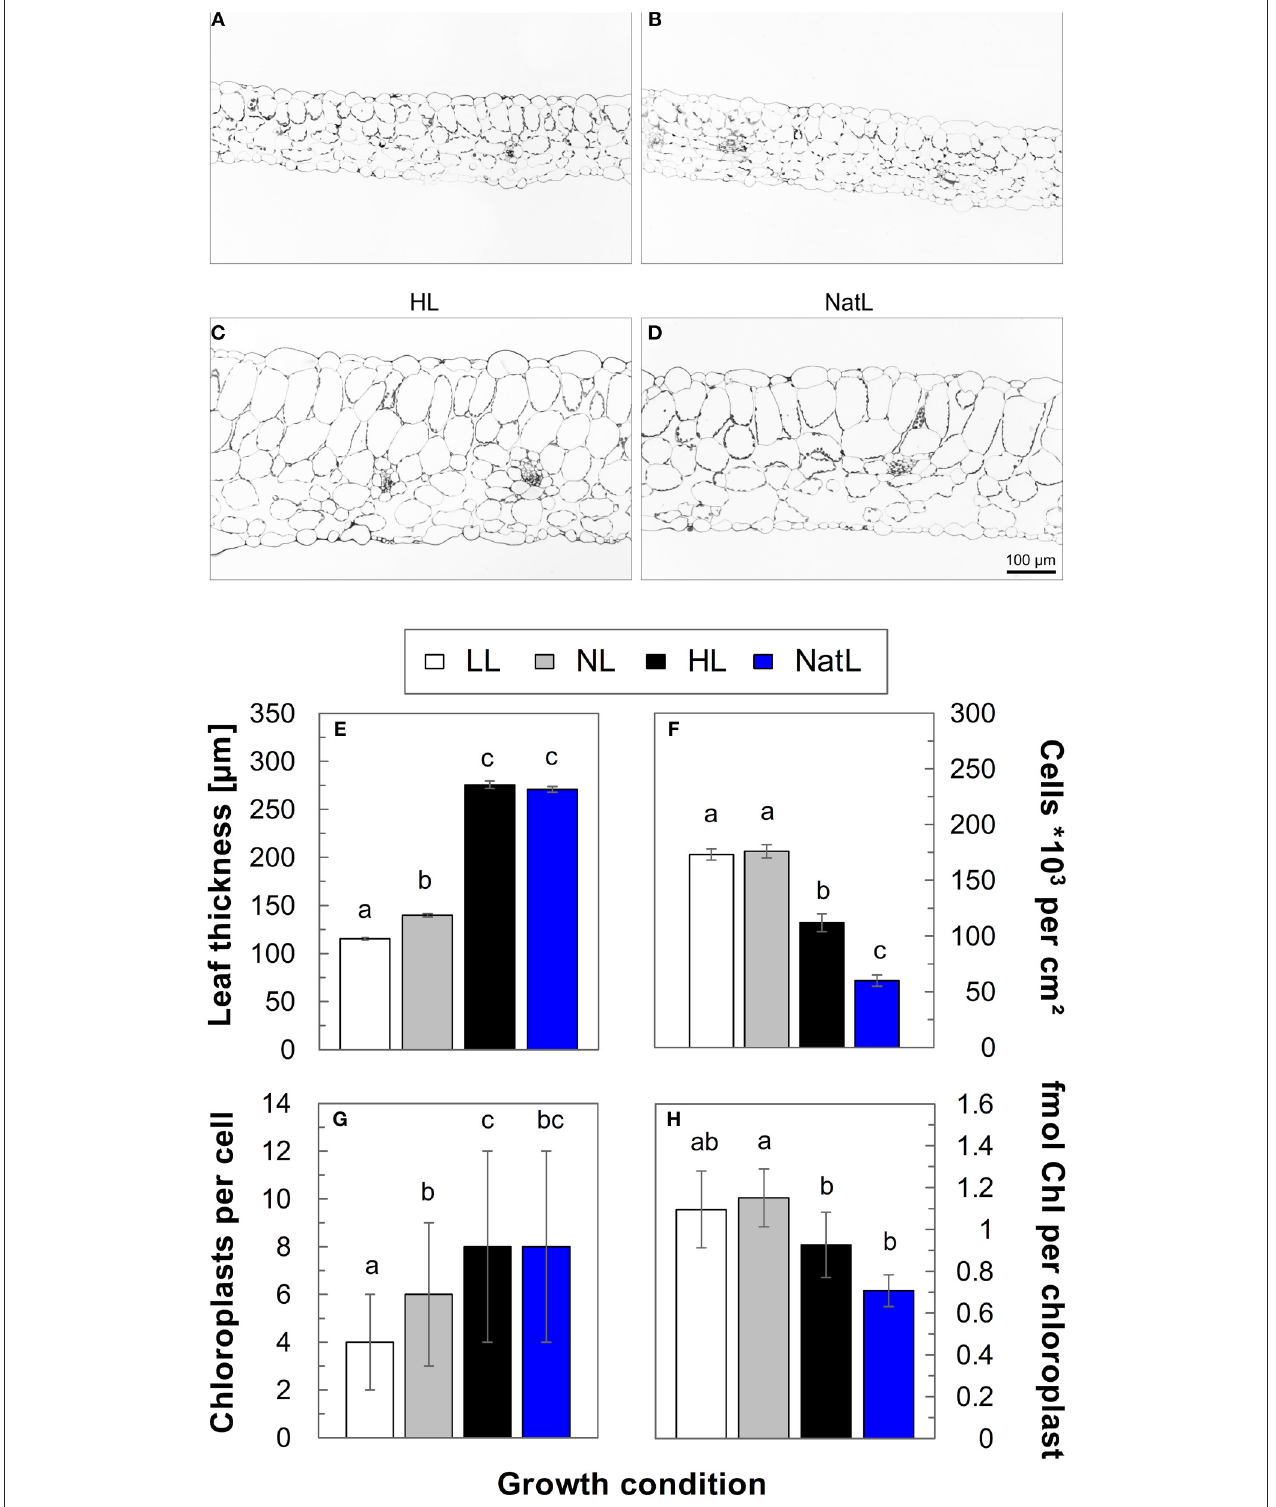
FIGURE 2 | Light microscopic analysis of leaf cross-sections. Upper panel: Light microscopic images of leaf cross-sections from (A) LL plants, (B) NL plants, (C) HL plants, and (D) NatL plants. Lower panel: Quantitative analysis of (E) leaf thickness, (F) the number of cells per cm 2 leaf area, (G) the number of chloroplasts per cell and (H) the number of Chl per chloroplast. Significant differences (Dunn’s test, p < 0.05) are indicated. Data represent mean values ± SE of at least 116 leaf cross-sections in (E) , of at least 32 leaf cross-section in (F) , of cells from at least 6 images in (G), and of at least 3 independent chloroplast preparations in (H) .